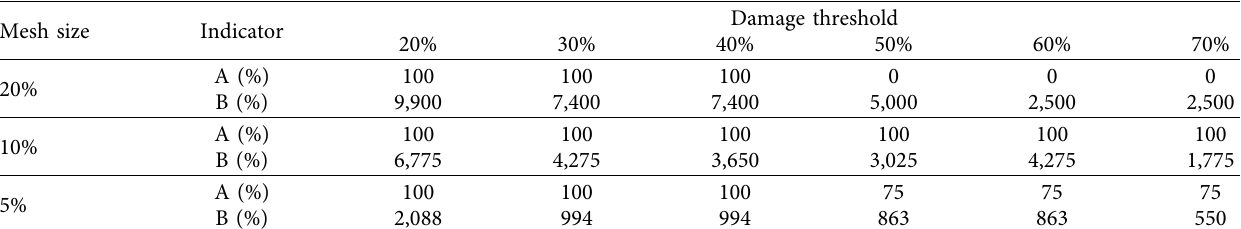
Table 5: Damage capacity indicators (%) for global MSE